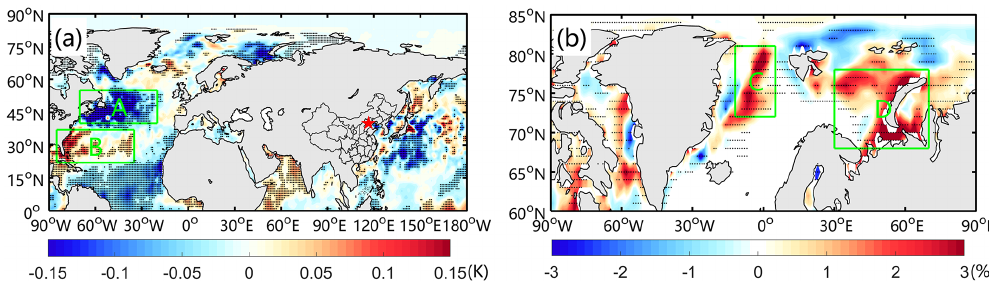
Figure 9. (a) Composite SST anomalies and (b) SIC anomalies for the 10d before the first day of the 65 persistent haze events. The dotted areas show values that are above the 95% confidence level based on a two-sided Student’s t test. The green rectangles A and B in (a) denote a north region (40–55 ◦ N, 70–20 ◦ W) and a south region (22–37 ◦ N, 85–35 ◦ W) over the North Atlantic, and the green rectangles C and D in (b) denote the Greenland Sea (12 ◦ W–5 ◦ E, 72–81 ◦ N) and the Barents Sea–Kara Sea (30–70 ◦ E, 68–78 ◦ N),